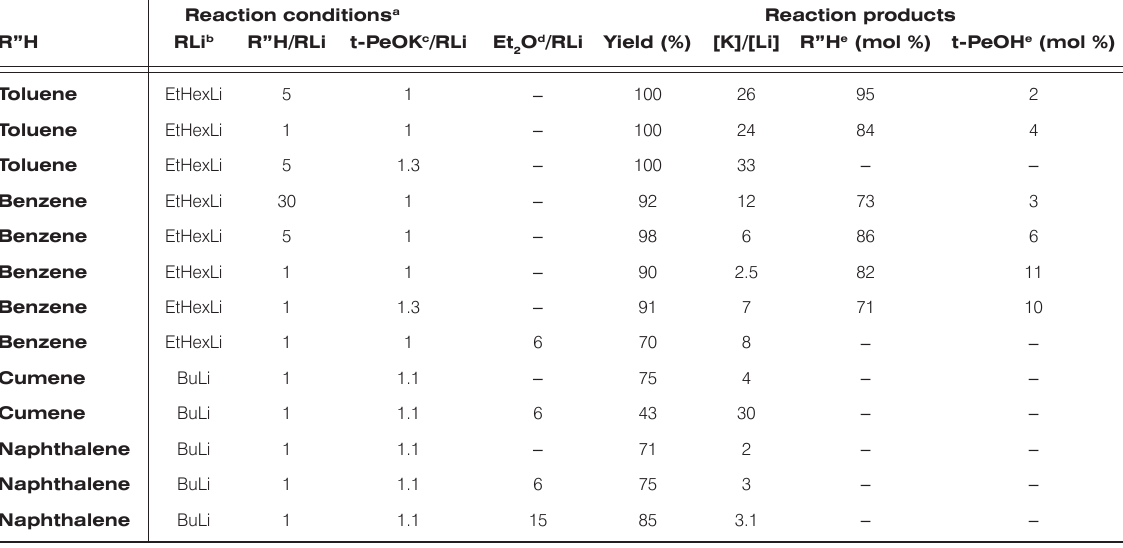
Table 1. Reaction of superbases with substrates R”H: R”H + RLi + t -PeOK = R”K + RH + t -PeOLi. Reaction conditions